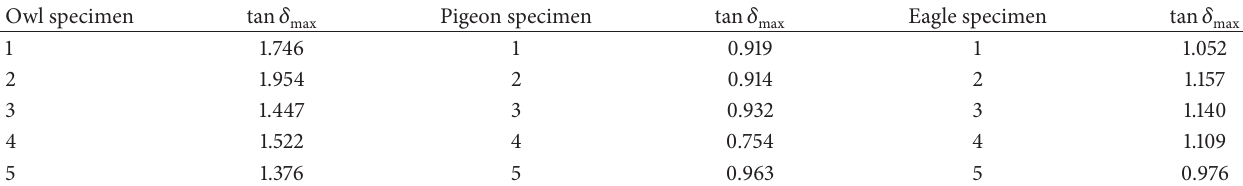
Table 2: Peak value of the loss tangent (tan 𝛿 ) of the feather shaft